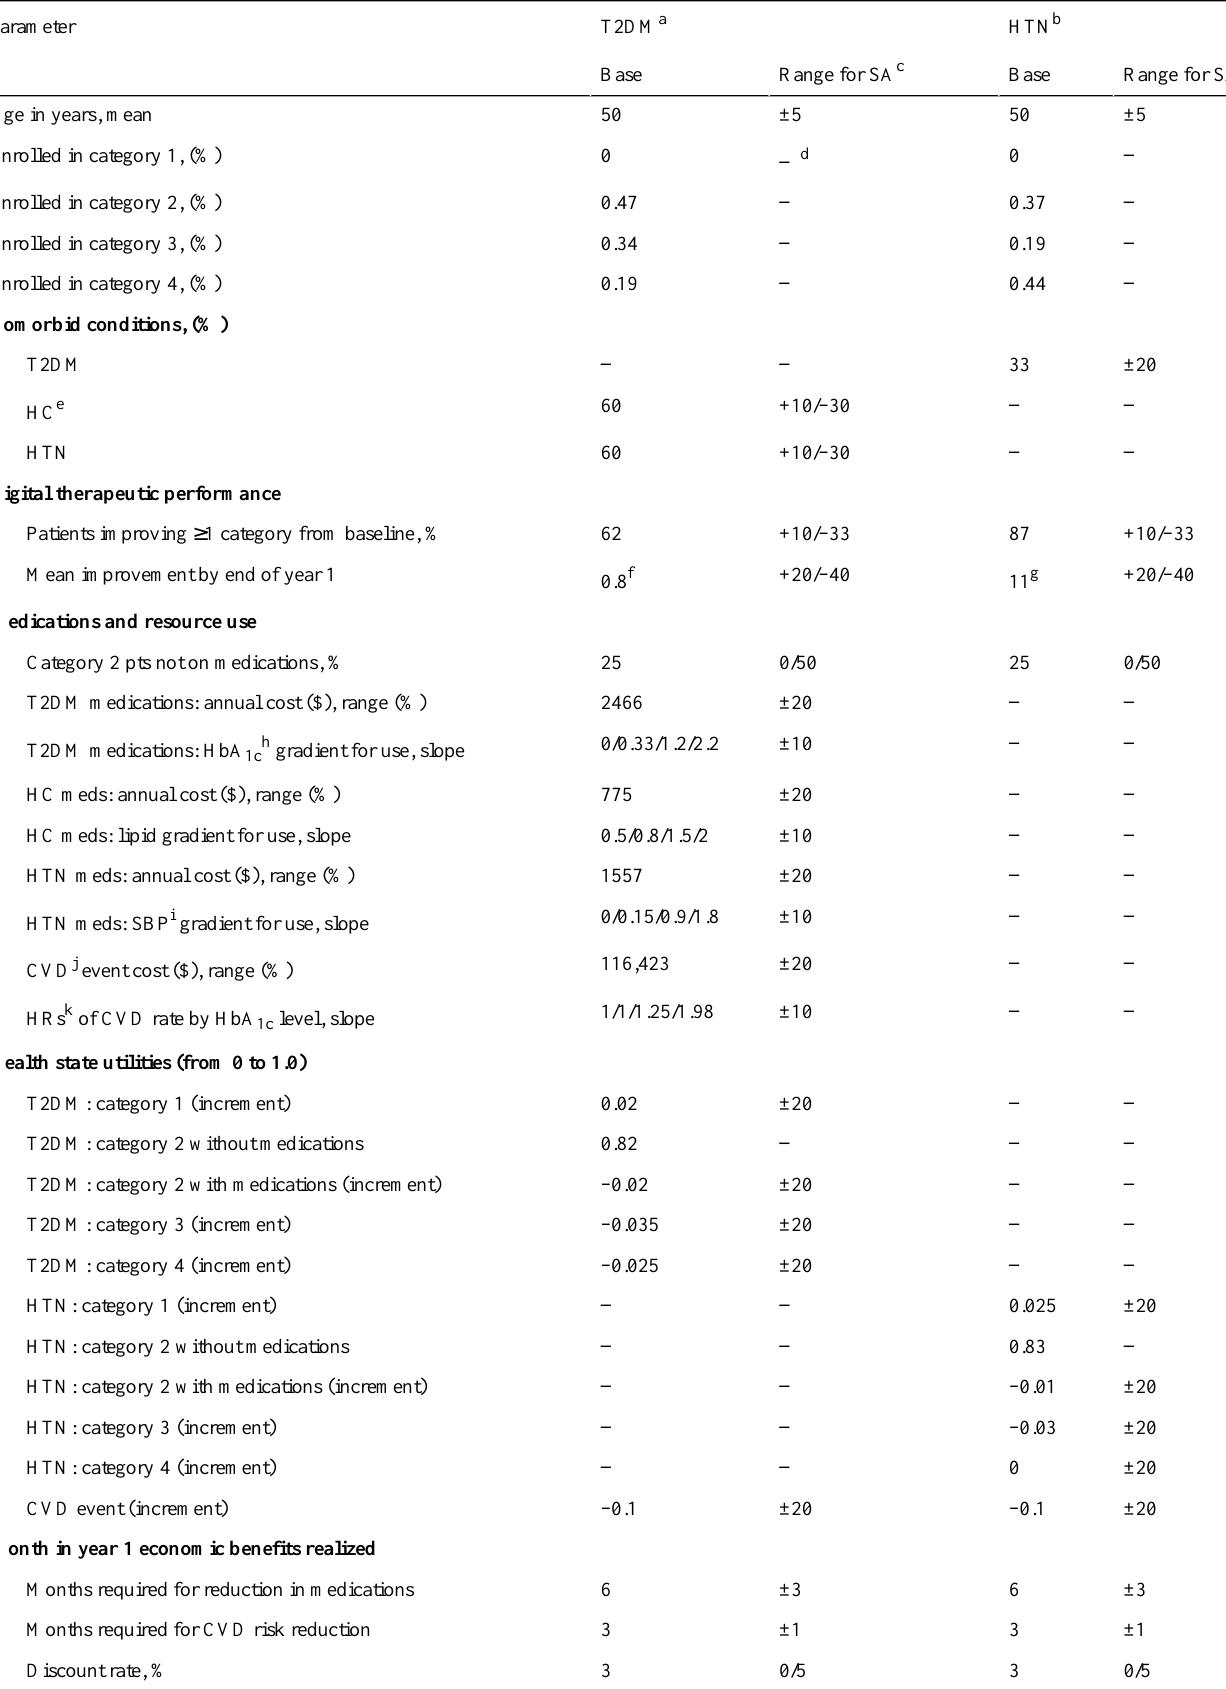
Table 1. Model input parameters and ranges for sensitivity